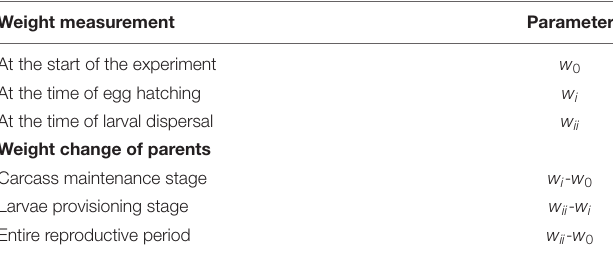
TABLE 1 | Measurements of weight and the calculation of weight change of parents during the first brood. Weight measurement